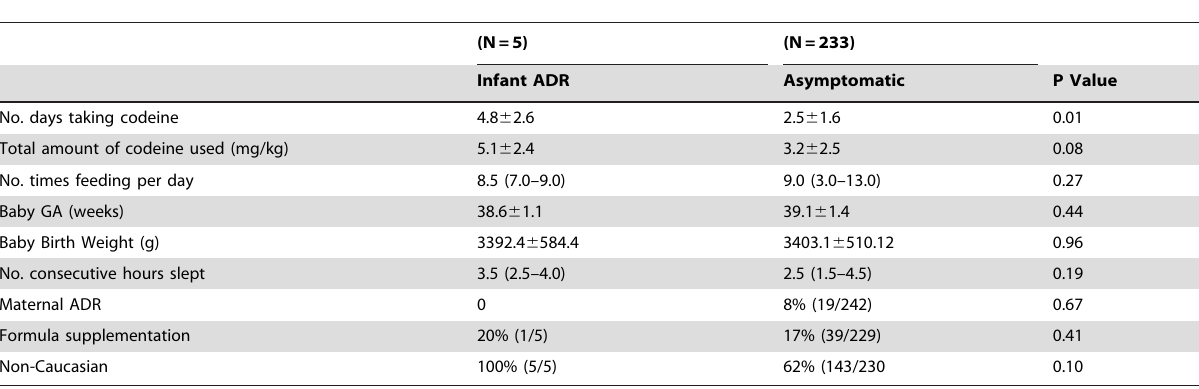
Table 1. The influence of clinical factors on neonatal sedation (Infant ADR).